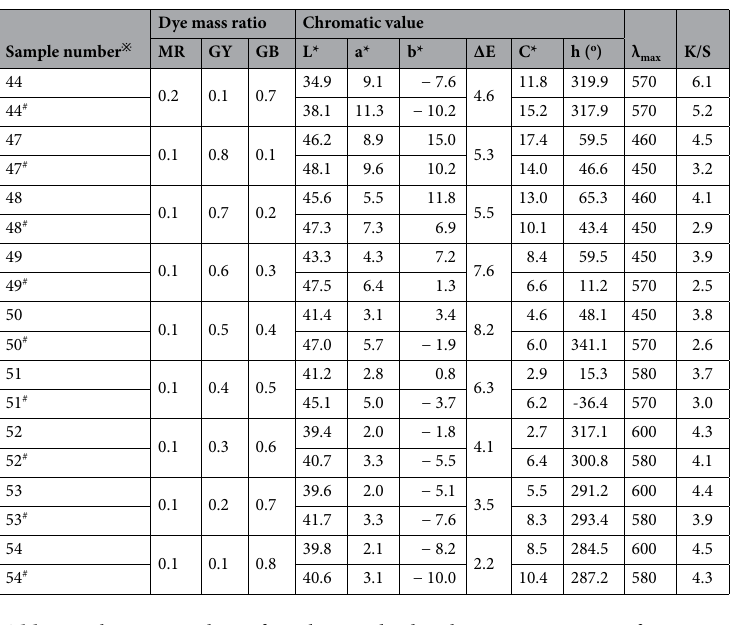
Table 4. Chromatic values of wool yarns dyed with ternary mixtures of MR, GY, and GB. ※ Sample number without and with # signal mean the dyed sample before and after soaping, respectively.